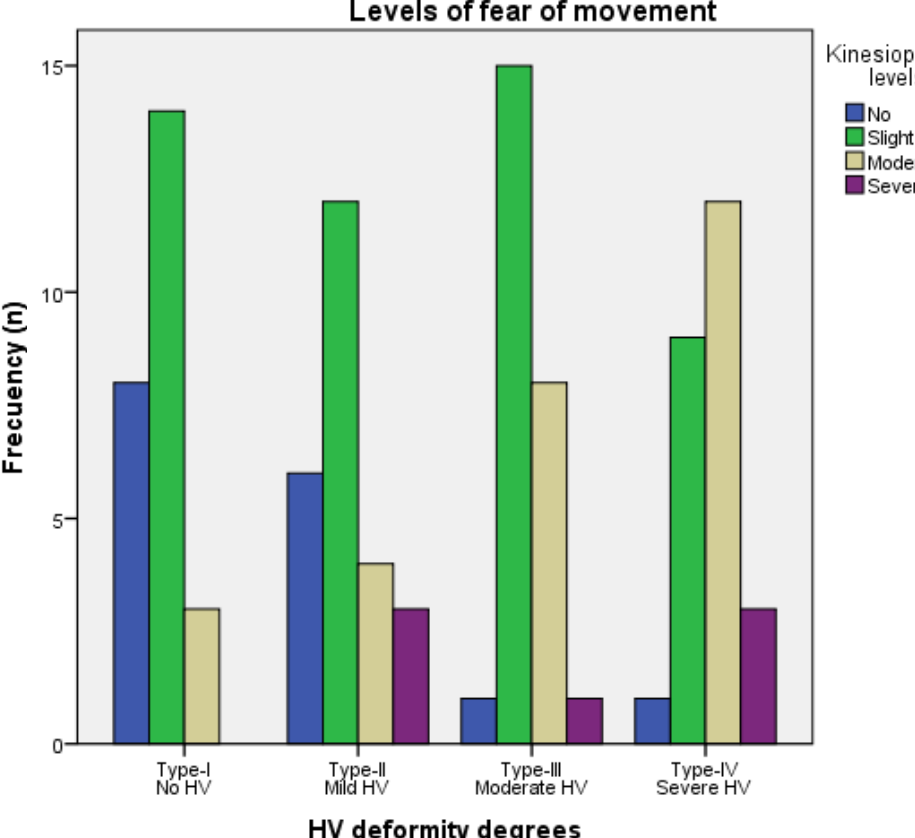
Figure 1. Bar graph showing the kinesiophobia levels of fear of movement (TSK-11), such as no fear (0 – 17 points), slight (18 – 24 points), moderate (25 – 31 points), severe (32 – 8 points), and maximum (39 – 4 points) kinesiophobia levels among different HV deformity degrees. Abbreviations : HV, hallux valgus; TSK-11, Tampa Scale of Kinesiophobia – 11 items.